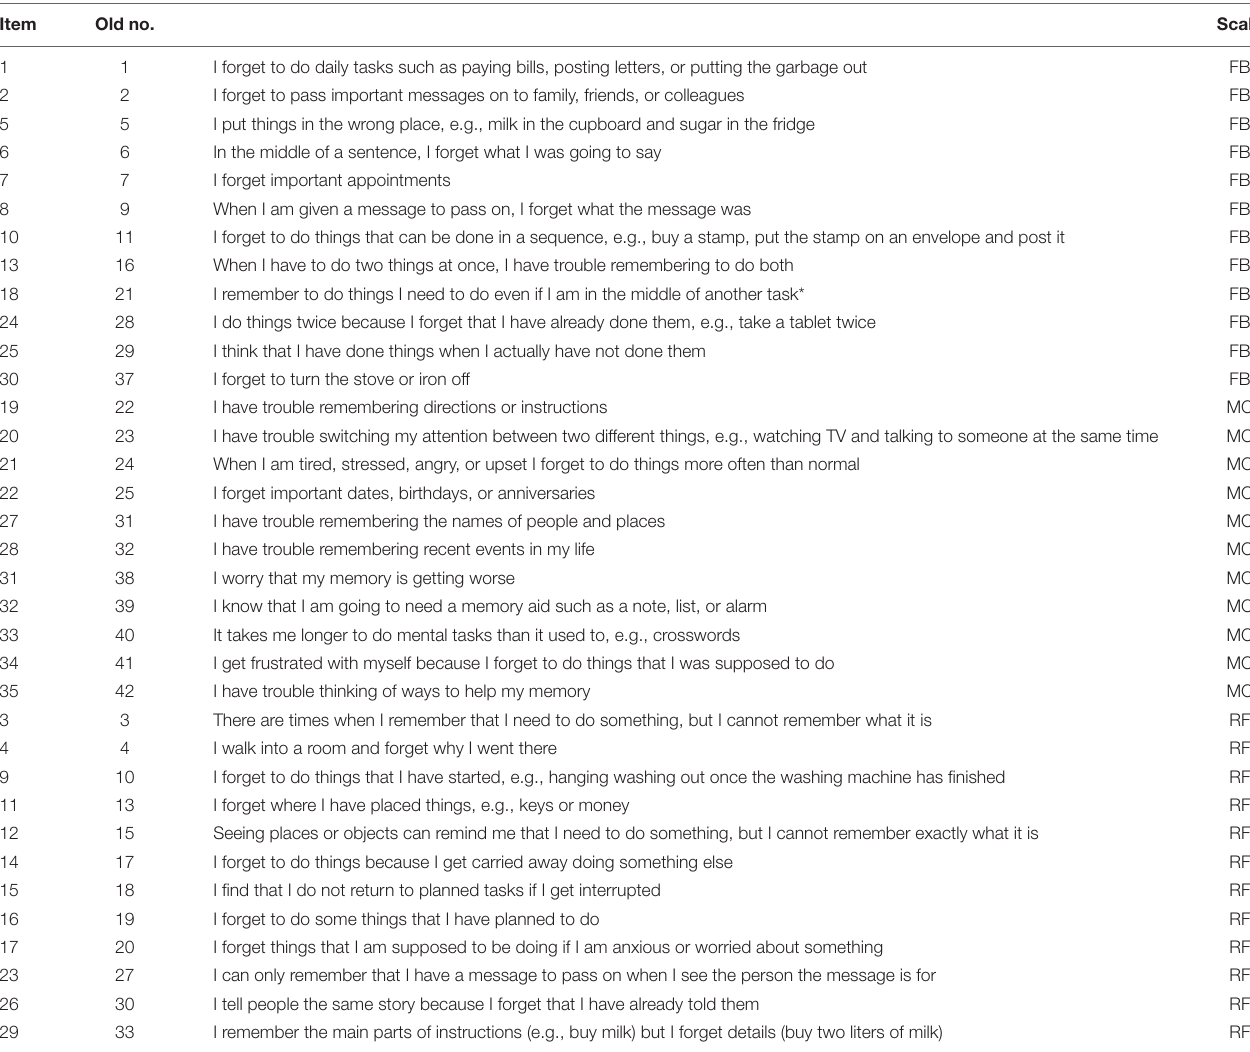
TABLE 2 | Items in the 35-item